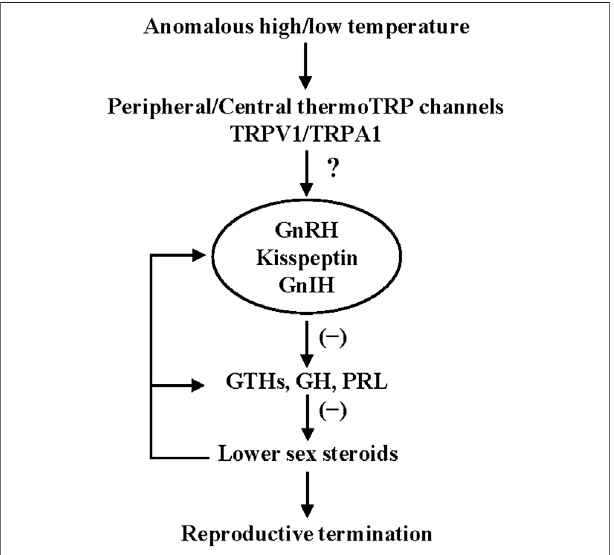
FIGURE 2 | Schematic representation of the proposed neuroendocrine mechanism of thermosensitive regulation of reproduction in fi sh. See the text for